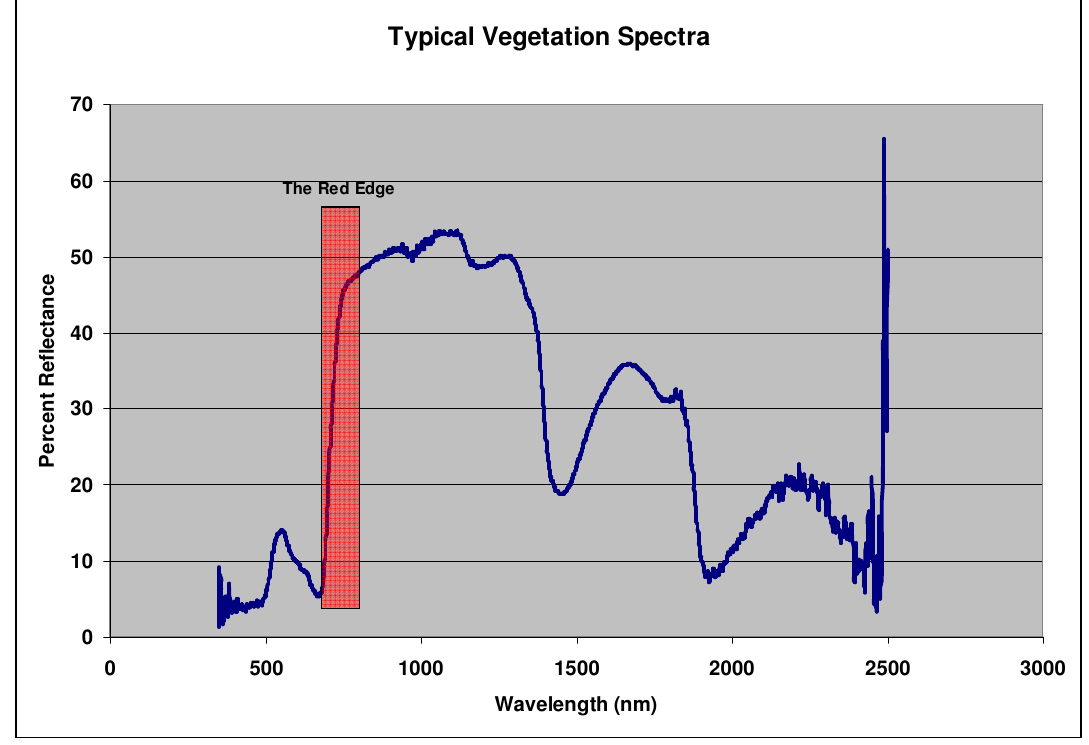
Figure 7. An important region of vegetation spectra is known as the Red Edge. Much research has focused on measuring shifts in this region corresponding to stress or enhancement of